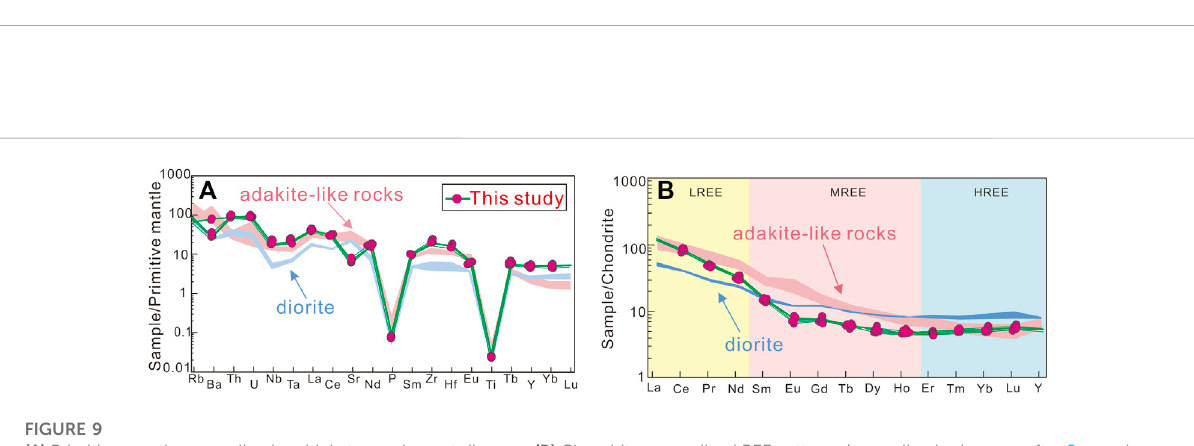
FIGURE 8 (A) TASdiagram(Middlemost,1994).ThedottedlineshowstheIrvineline(IrvineandBaragar,1971). (B) Alkalinityratio(A.R.)vs.SiO 2 plot(Wright, 1969). (C) SiO 2 vs. K 2 O plot (Peccerillo and Taylor, 1976). (D) Molar A/CNK vs. Molar A/NK plot (Maniar and Piccoli, 1989). (E) Y vs. Sr/Y plot (after Defant and Drummond, 1990; modi fi ed from Meng et al., 2021). (F) SiO 2 vs. molar A/CNK diagram (I-type granitic fi eld is after Clemens et al., 2011).